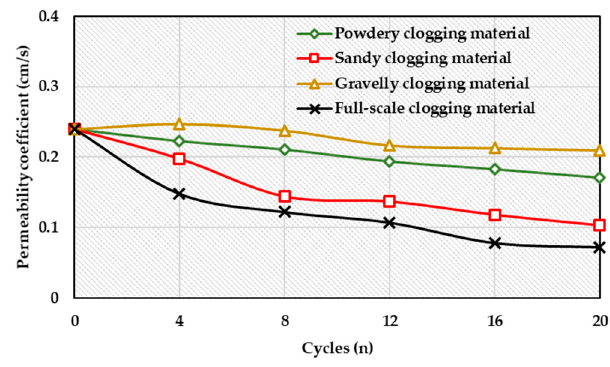
Figure 13. Permeability coefficient of COF-OGFC with different clogging materials.